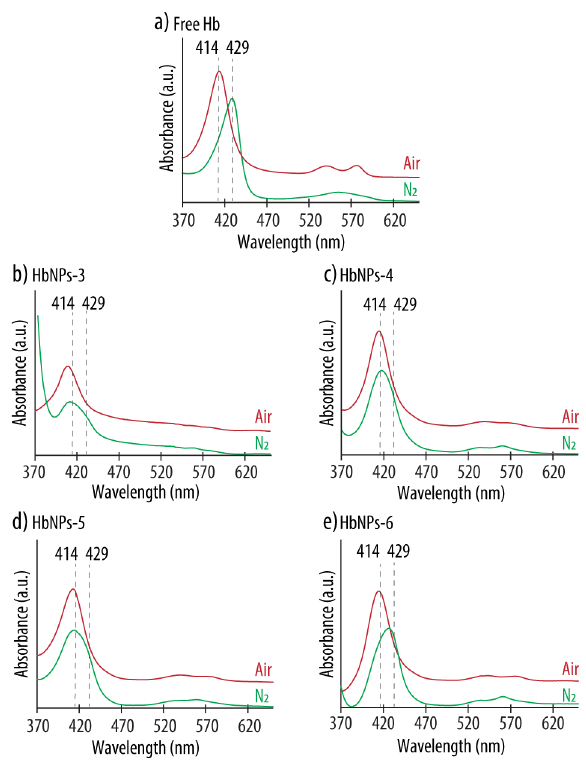
Figure 1. UV-vis absorption spectra of native Hb ( a ) and HbNPs ( b – e ) fabricated with increasing Hb concentrations (i.e., 25, 50, 75 and 100 mg mL − 1 for HbNPs-3, HbNPs-4, HbNPs-5 and HbNPs-6, respectively) before (red line) and after (green line) purging with nitrogen (N 2 ) gas. The HbNPs were prepared using 12.5 mg mL − 1 PLGA and 1%